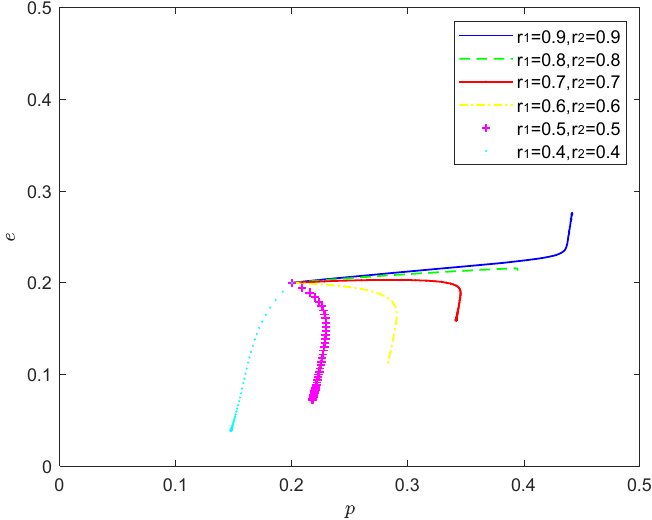
Figure 4. Evolution of game strategy in (optimistic, optimistic) state.